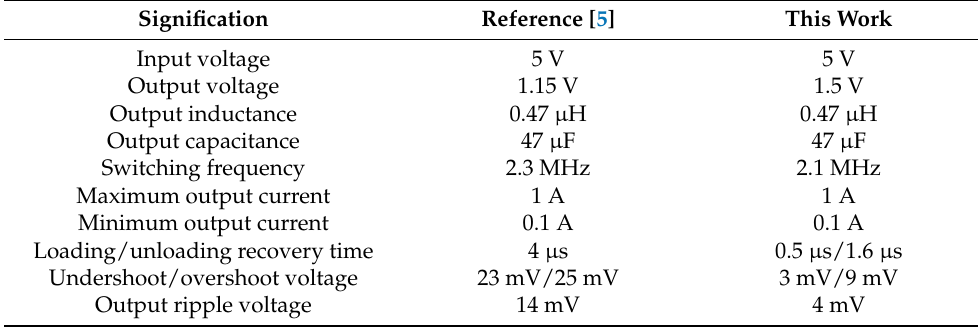
Table 5. Comparison with Reference